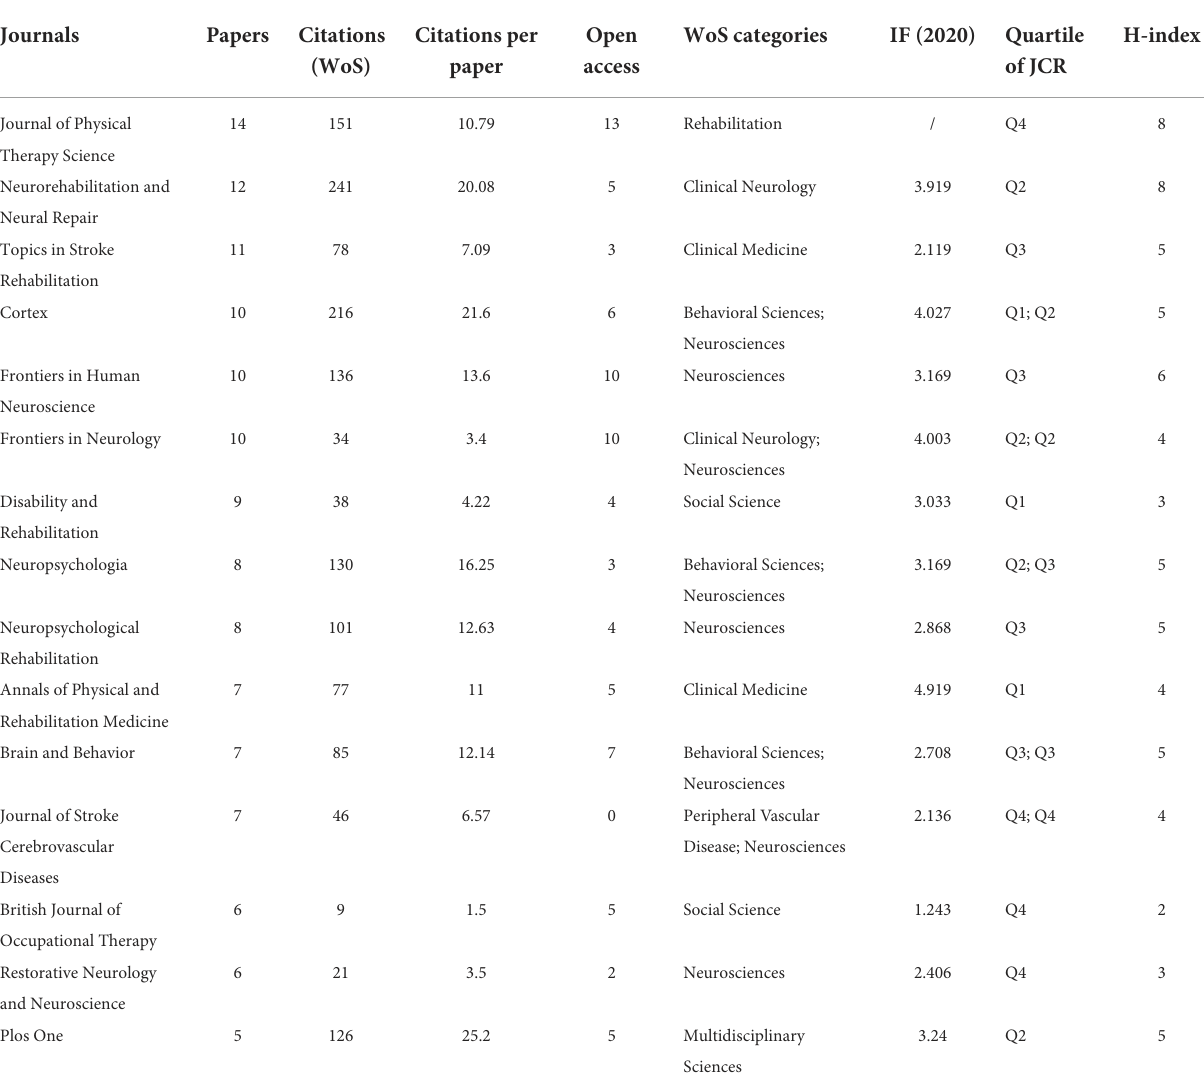
TABLE 1 The top 10 journals ranked by the number of publications.